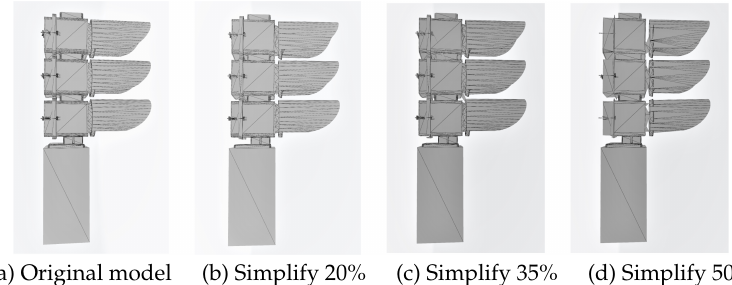
Fig. 10. Comparison of the simplified results of the starting signal